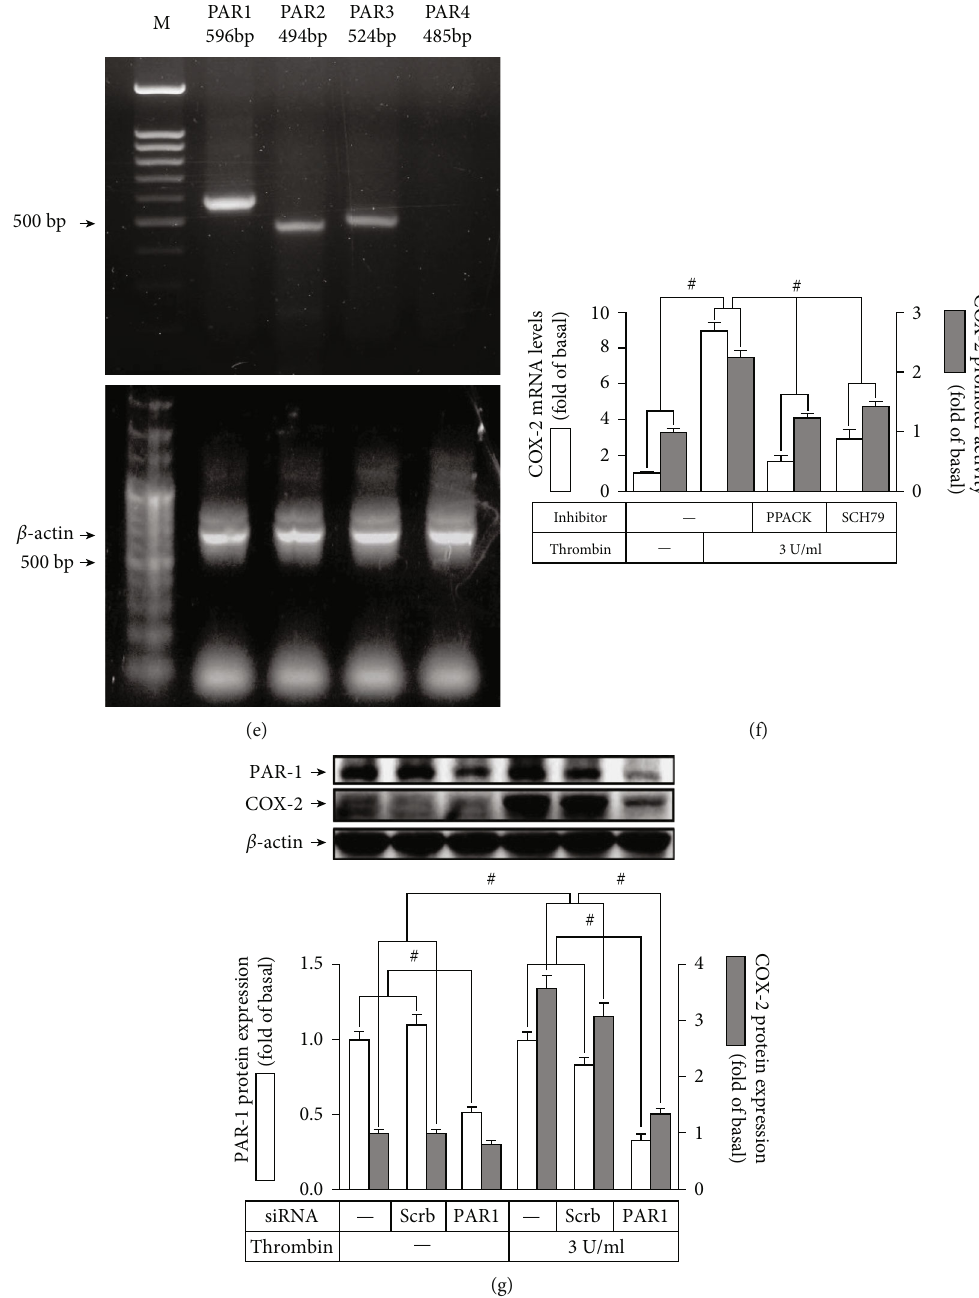
Figure 1: Thrombin induces COX-2 expression via PAR1. (a) Cells were treated with thrombin (1, 3, or 10 U/ml) for the indicated time intervals. The protein expression of COX-2 was determined by Western blot. (b, c) Cells were treated with 3U/ml thrombin for the indicated time intervals. The COX-2 (b) mRNA levels and (c) promoter activity were determined by real-time PCR and promoter assay, respectively. (d) Cells were treated with 3 U/ml thrombin for the indicated time intervals or pretreated with 10 μ M CLC or 10 μ M NS- 398 for 1 h and then treated with thrombin for 8h. The PGE generation was measured. (e) The levels of PAR1 , PAR2 , PAR3 , PAR4 , and 2 β -actin (as an internal control) mRNA on HTSMCs were determined by RT-PCR. (f) Cells were pretreated with PPACK (3 μ M) or SCH79797 (10 μ M) for 1h and then incubated with thrombin for 4 h. The mRNA levels and promoter activity of COX-2 were determined. (g) Cells were transfected with either scrambled or PAR1 siRNA and then incubated with thrombin for 6 h. The protein levels of PAR1 and COX-2 were determined by Western blot. Data are expressed as mean ± S : E : M : of three independent experiments. # P < 0 : 05 , as compared with the control or pretreatment with inhibitor indicated in the fi